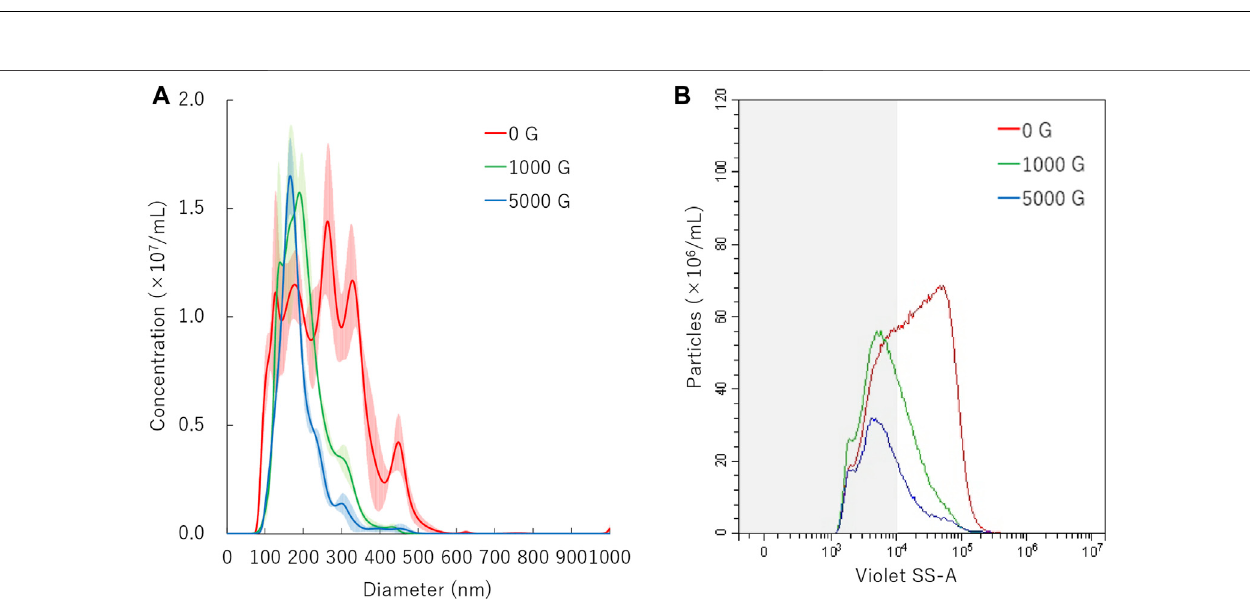
FIGURE3| Nanobubblessizedistributionaftercentrifugation. (A) Sizedistributionofnanobubbles(NTA)withorwithoutcentrifugation. (B) Theconcentrationsand size distribution of nanobubbles with or without centrifugation (FCM). Gray shaded area indicates nanobubbles size less 200 nm.